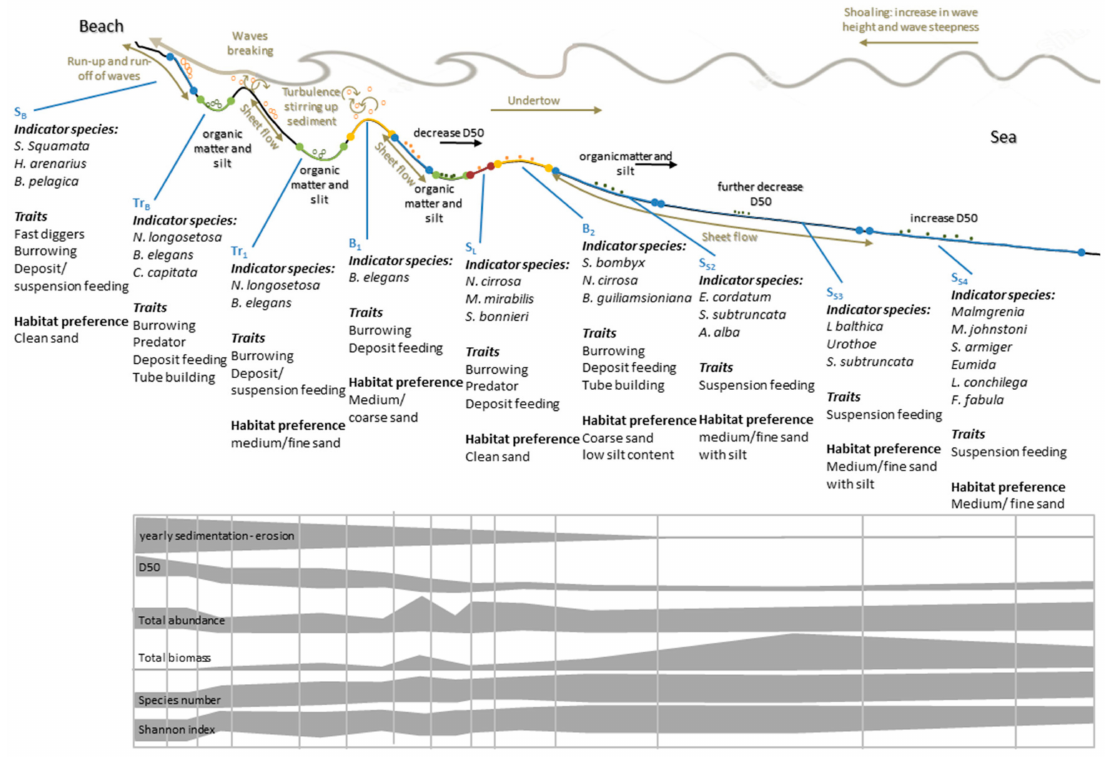
Figure 9. Conceptual drawing of the cross-shore wave related processes (adapted from van der Zanden (2016) [27]), environmental parameters measured and the macrobenthic species identified as indicator species for the morphological